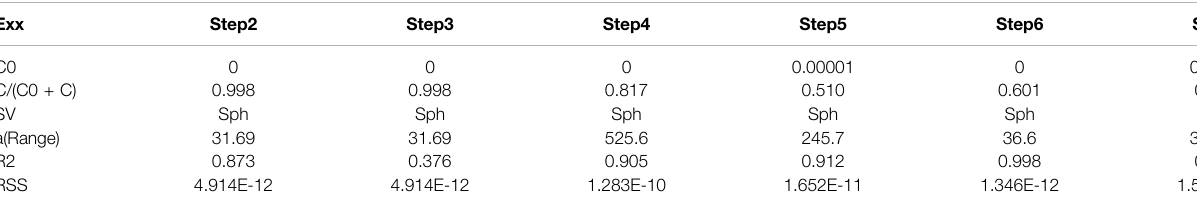
TABLE 1 | Spatial variability of strain fi elds under different stress strengths.